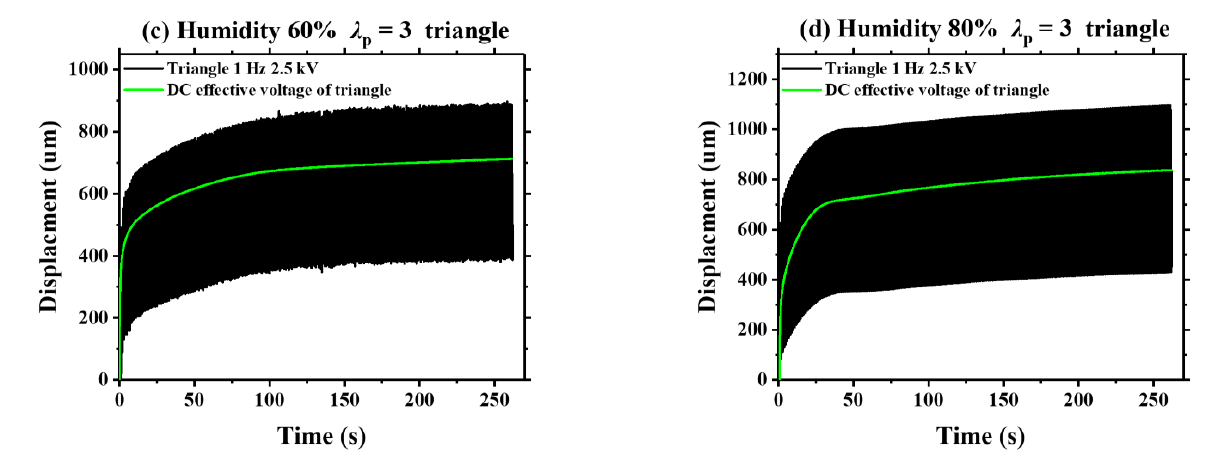
Figure 9. Comparison of the displacements between the effective DC signal and the triangle signal under different ambient humidities.